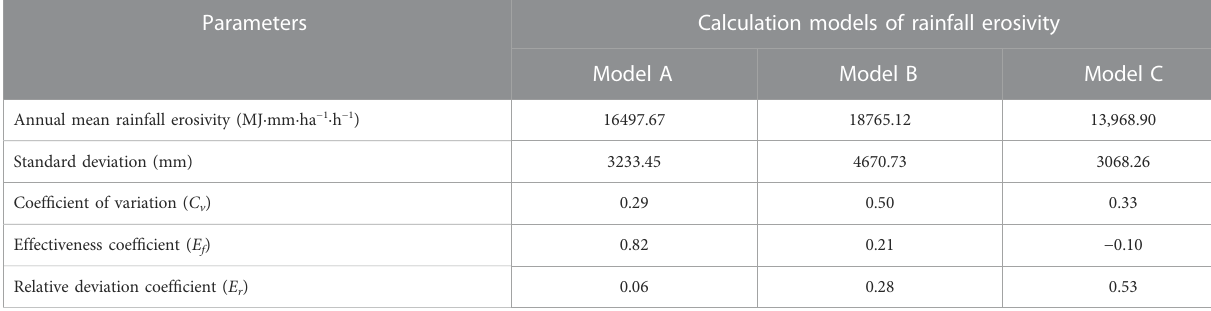
TABLE 2 Evaluation on suitability of different rainfall erosivity calculation